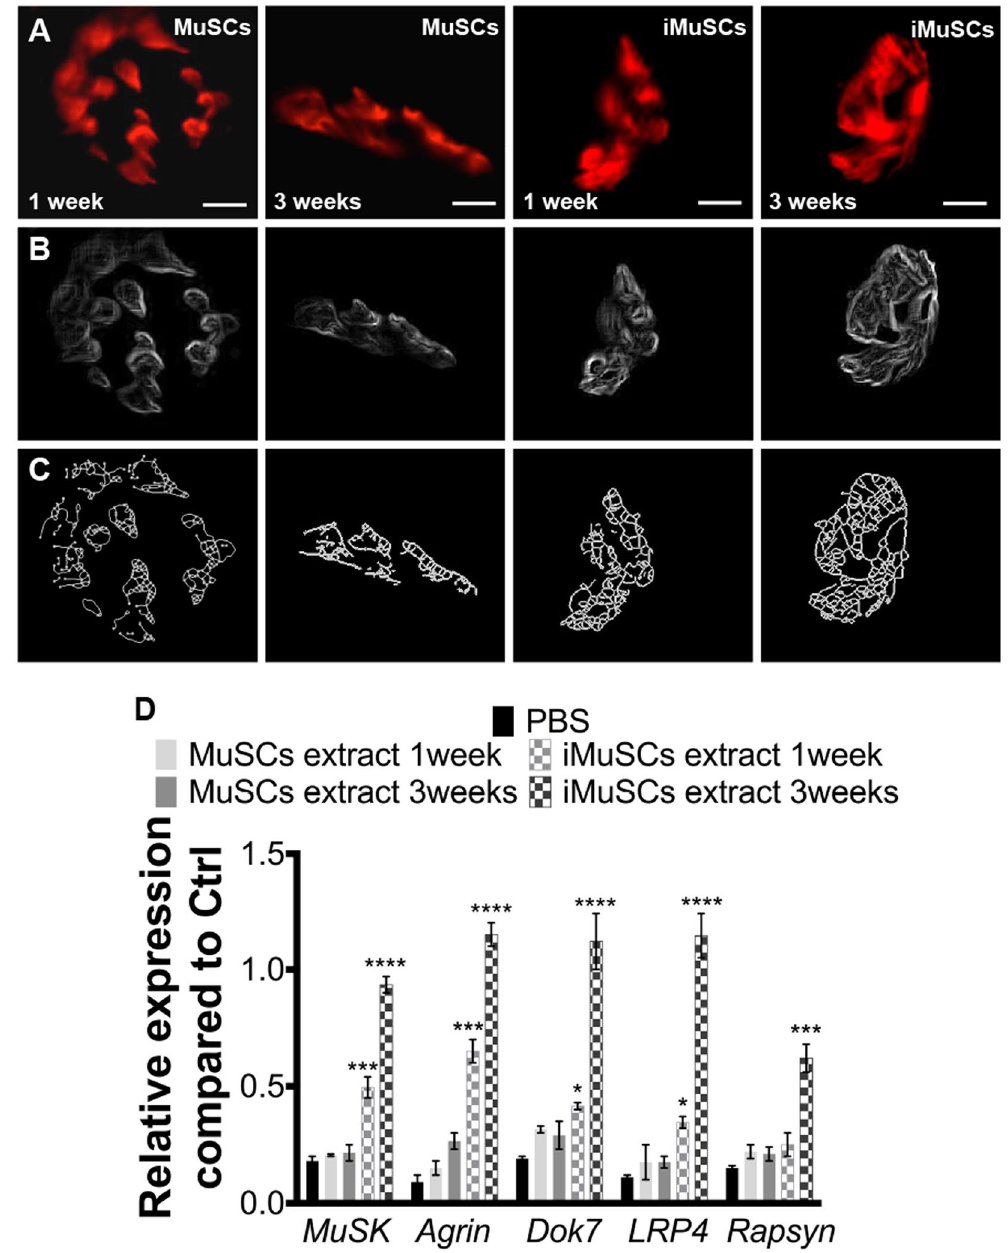
Figure 7. NMJ recovery after injection of iMuSC extracts into mdx mice. ( A ) Representative IF images of NMJs after injection with MuSC and iMuSC extracts into the GMs of mdx mice (red, A ). ( B ) Processed binary images and ( C ) skeletonized images show discontinuity and branching patters. ( D ) Expression of MuSK complex constituents. Data are presented as mean ± SEM of five biological replicates. * P < 0.05, ** P < 0.01, *** P < 0.001, **** P <